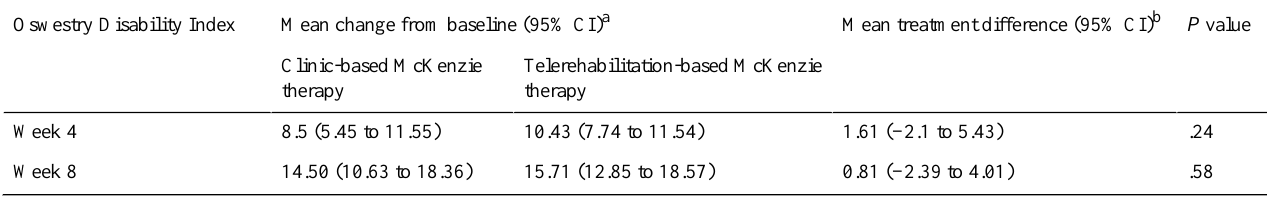
Total cost per participant (US$)Cost per visit (US$)Resources